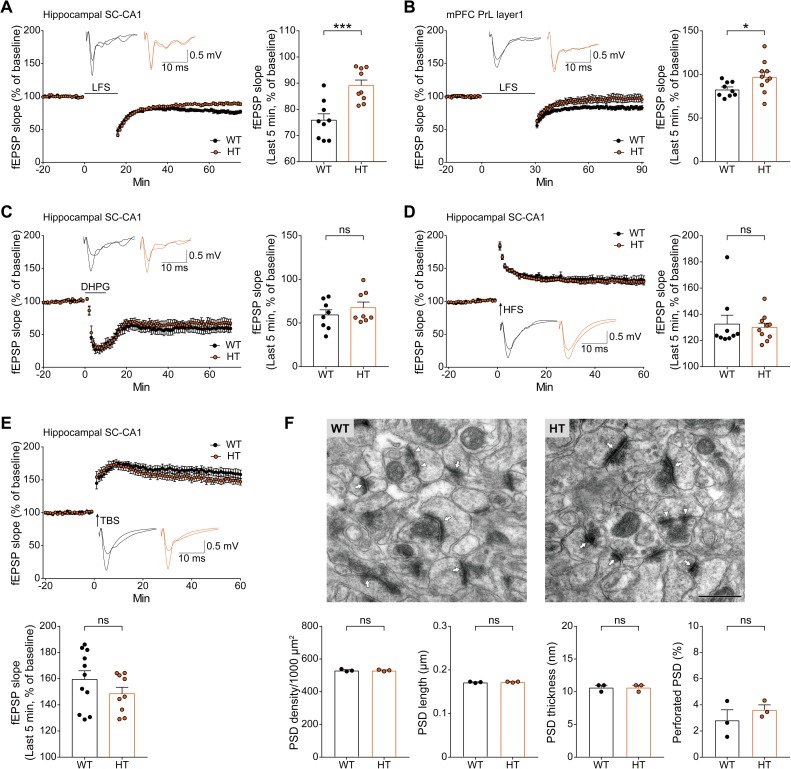
Reduced LFS-LTD but normal mGluR-LTD, HFS-LTP, TBS-LTP, and PSD density and morphology in the Grin2b+/C456Y hippocampus.(A) Reduced LFS-LTD at SC-CA1 synapses of Grin2b+/C456Y mice (P17–19). n = 9 neurons from 7 mice for WT (75.9% ± 2.4%), and 9 (5) for HT (89.1% ± 2.1%), ***P < 0.001, Student t test. (B) Reduced LFS-LTD in the PrL 1 region of the mPFC in Grin2b+/C456Y mice (P17–20). n = 9 neurons from 5 mice for WT (82.9% ± 2.8%), and 10 (5) for HT (97.3% ± 5.8%), *P < 0.05, Student t test. (C) Normal mGluR-LTD induced by the group I mGluR agonist DHPG (50 μM for 10 minutes) at SC-CA1 synapses of Grin2b+/C456Y mice (P16–20). n = 8 (6) for WT (59.3% ± 5.8%), and 8 (4) for HT (67.6% ± 6.4%), Student t test. (D) Normal HFS-LTP at SC-CA1 synapses of Grin2b+/C456Y mice (P27–33). n = 9 (5) for WT (132.5% ± 6.8%), and 10 (4) for HT (130.0% ± 3.2%), Mann-Whitney test. (E) Normal TBS-LTP at SC-CA1 synapses of Grin2b+/C456Y mice (P28–32). n = 11 (6) for WT (159.4% ± 6.6%), and 9 (4) for HT (148.5% ± 4.9%), Student t test. (F) Normal PSD density and morphology (length, depth, and perforation) in the CA1 region of Grin2b+/C456Y mice (P21). n = 3 mice for WT and HT, Student t test. The numerical data underlying this figure can be found in S3 Data. DHPG, dihydroxyphenylglycine; fEPSP, field excitatory postsynaptic potential; HFS, high-frequency stimulation; HT, heterozygous; LTD, long-term depression; LFS, low-frequency stimulation; LTP, long-term potentiation; mGluR, metabotropic glutamate receptor; mPFC, medial prefrontal cortex; ns, not significant; P, postnatal day; PrL, prelimbic layer; PSD, postsynaptic density; SC-CA1, Schaffer collateral-CA1 pyramidal; TBS, theta burst stimulation; WT, wild type.